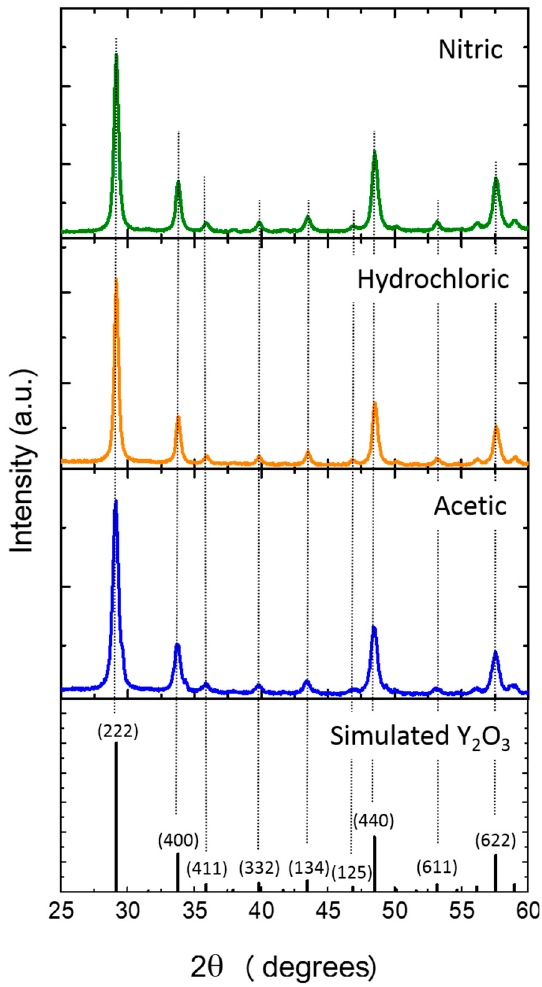
Figure 4. XRD diffractograms of Yb/Eu doped Y 2 O 3 nanostructures after calcination at 700 ° C. The simulated Y 2 O 3 powder pattern is also shown for comparison.